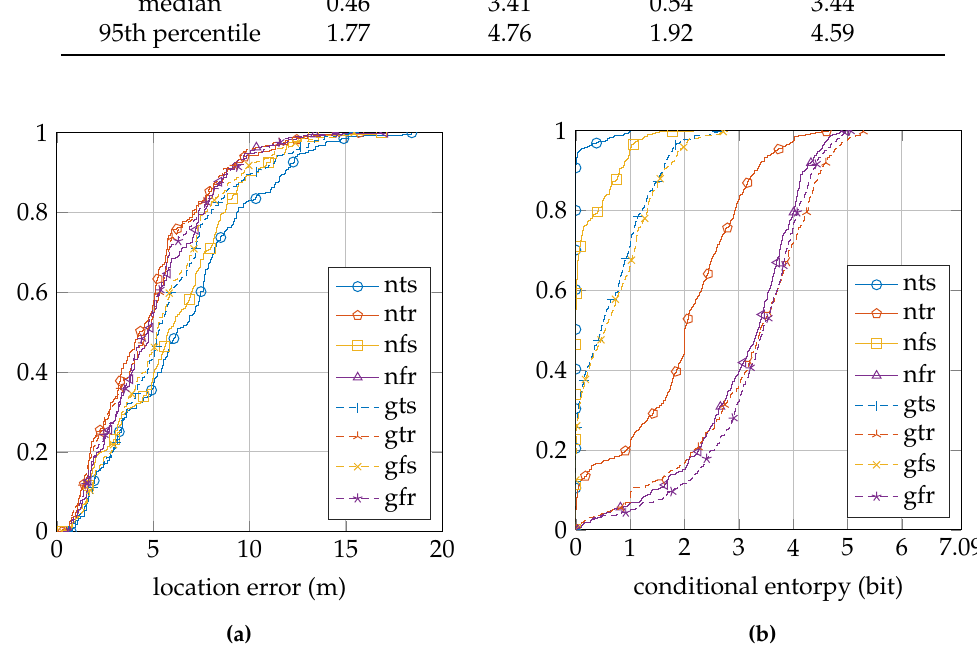
Figure 8. GEOTEC cumulative distributions: ( a ) location error; ( b ) conditional entropy. The legend labels refer to using the normal sensor model (n) or using the convolution sensor model (g), using the trained σ (t) or using the fixed σ (f) and using a single reference location for training (s) or using a region of reference locations for training